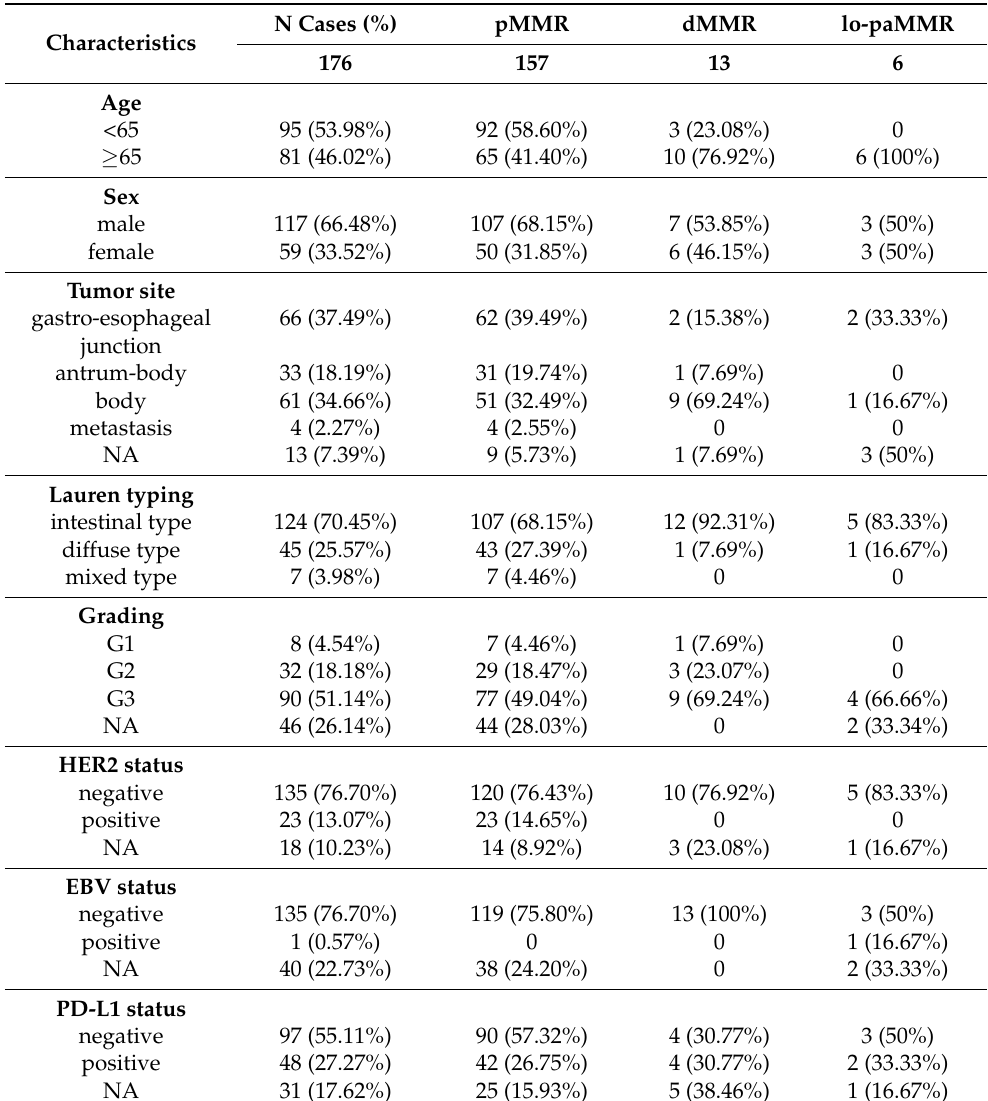
Table 4. Clinical and pathological features of GC